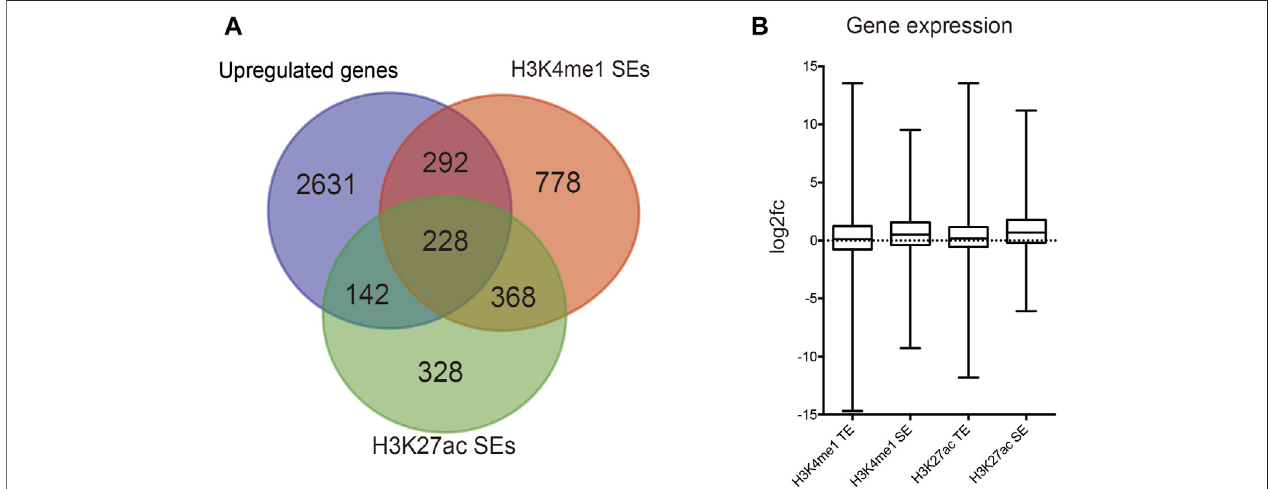
FIGURE 3 | Identi fi cation of SE-regulated key cell identity genes. (A) Venn diagram showing the overlap between SEs marked by H3K27ac and H3K4me1 signals and upregulated genes in TSCs. (B) Relative gene transcript levels in SEs and TEs marked by H3K27ac and H3K4me1 signals.